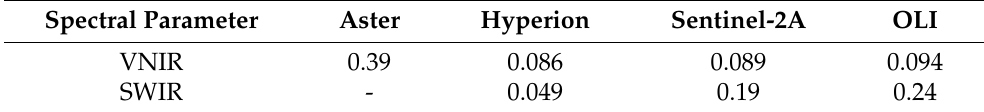
Table 6. Spectral similarity of soil samples and images spectra calculated by the SAM method.